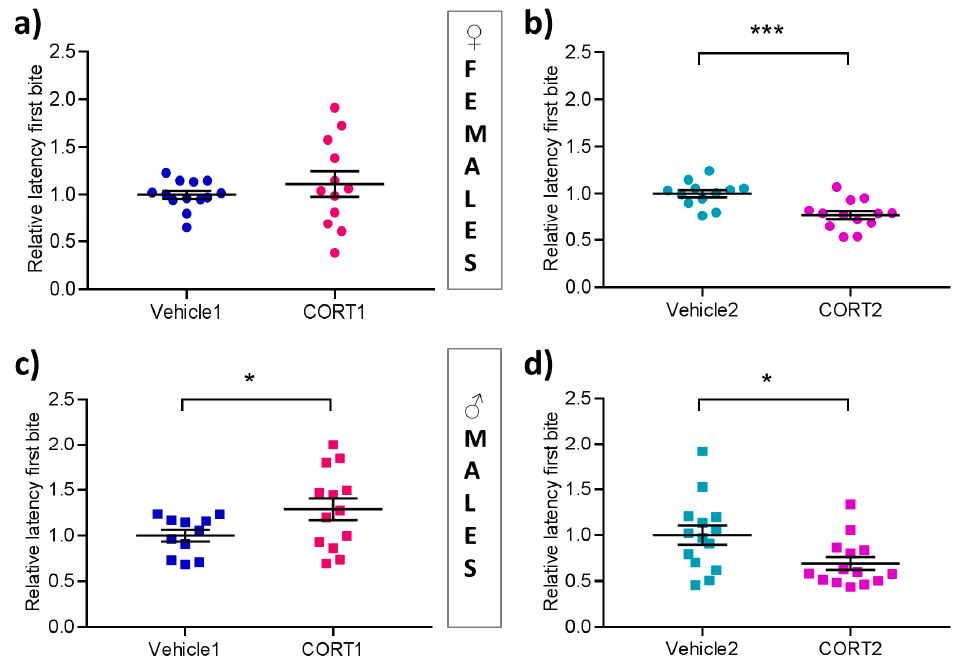
Figure 3. Novelty Suppressed Feeding test in CORT treated and control mice. Behavioral outcome of the novelty suppressed feeding test showing relative latencies until the first bite in ( a–b ) female ( c–d ) male mice of each CORT and Vehicle group. All values are presented as mean ± SEM ( n = 11–14 per group). Statistical significances are results of Student‘s t-test. * p < 0.05, *** p < 0.001.